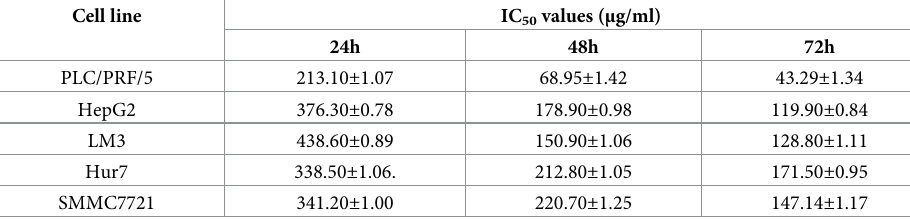
Table 1. IC 50 values of DHW extract on different cell